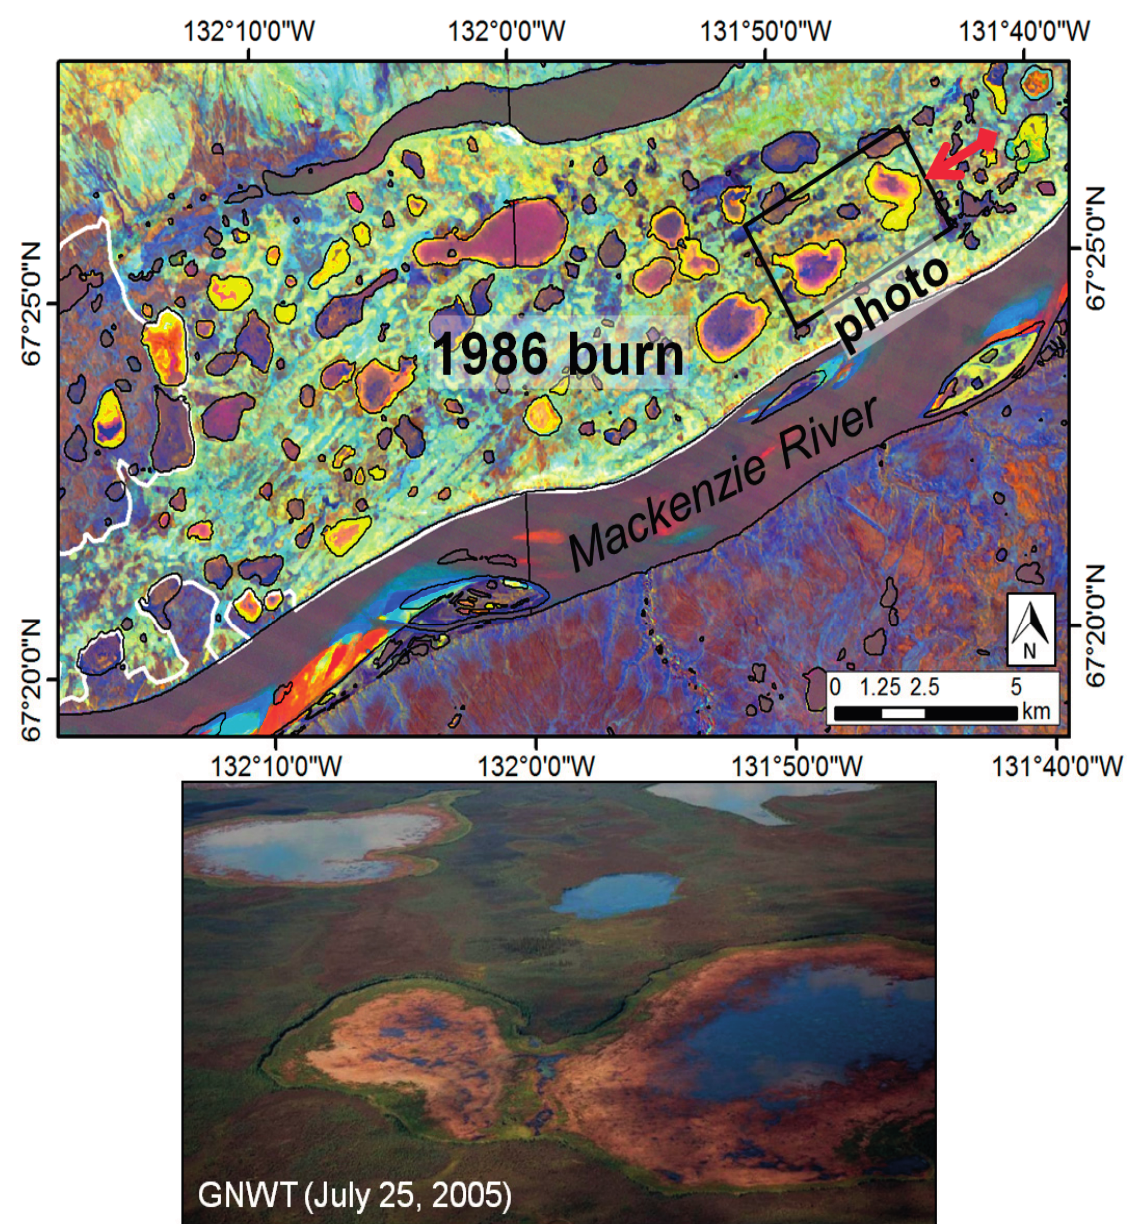
Figure 9. TC trend image ( top ) showing draining or drying of shallow lakes (yellow) within a 1986 burn. Historical lake perimeter from the National Hydro Network are overlaid showing ~1950 lake extents. Exposed and vegetating lake beds are visible in recent oblique air photos from the NWT Government ( bottom ). The red arrow shows the direction from which the photo was